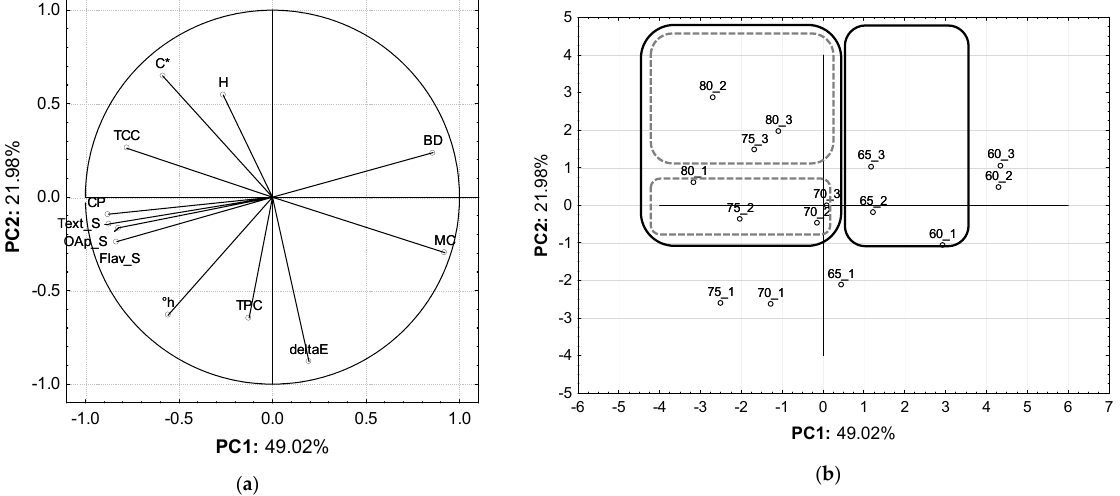
Figure 7. Principal component analysis (PCA) of SP samples as affected by different dried temperatures (60°, 65°, 70°, 75° and 80 °C) at 200 min: (a) score plot and (b) loading plot. C*–Chroma, °h–hue angle, deltaE–Total Color Difference, MC–Moisture Content, H–Hardness, BD–Breaking Distance, CP–Crispness, TPC–Total Phenolic Content, TCC–Total Carotenoid Content, Text_S–Texture (sensorial), Flav_S–Flavor (sensorial) and OAP_S–Overall Appreciation (sensorial). In Figure 7a, the vector projection of the variable PC1 reveals that favourable sensory appreciation (Text_S, Flav_S and OAp_S) significantly depended on increasing sample crispness (CP) resulting from higher drying temperature, as all these variables correlate negatively with PC1. On the other hand, the inverse correlation of the CP and BD variables with PC1 shows the dependence of these texture properties on dry products. The higher the distance to break off the sample, the lower the level of the food´s crispness. The projection of the TCC variable onto PC1 (significantly inverse correlation) supports the previously mentioned trend between higher drying temperatures (75° to 80 °C) and higher sample’s carotenoid content. The opposite correlation of TCC and moisture content (MC) variables with PC1 reveals a concentration effect. Additionally, it was found that the inverse correlation of all sensory variables and MC along PC1 reveals that lower MC values (ca 10%) leads to high sensory acceptance, only reached for drying temperatures greater than 75 °C (Figure 1b). PC2 (which explains 21.98% of the data variability) describes the dynamics of color change between samples at different temperatures (Figure 7a). It is represented only by deltaE variable negatively correlated with PC2. This indicates that samples’ total color changes, regardless of temperature, did not influence the SP´s sensory acceptance. This conclusion agrees with the results of the color sensory appreciation of the samples (t = 200 min) (Figure 6), whose ratings showed no significant differences (t = 200 min), regardless of drying temperature. The score plot (Figure 7b) indicates sample grouping as revealed by the hierarchical cluster analysis dendrogram (Figure 8). According to sample clustering, the first division into two groups over PC1 separates the samples dried at 60 °C from the others. As a result, the conclusion that this temperature does not ensure SP chips with acceptable sensory and bioactive quality is also supported.